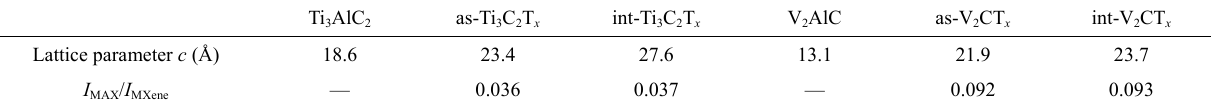
Fig. 1 XRD patterns of MAX phases, as-MXenes, and int-MXenes: (a) Ti 3 AlC 2 and Ti 3 C 2 T x , (b) V 2 AlC and V 2 CT x . Table 1 XRD data of MAX phases and MXenes. Lattice parameter c was calculated from 2 θ of (002) peak and I MAX / I MXene is intensity ratio of MAX’s (002) peak to MXene’s (002)